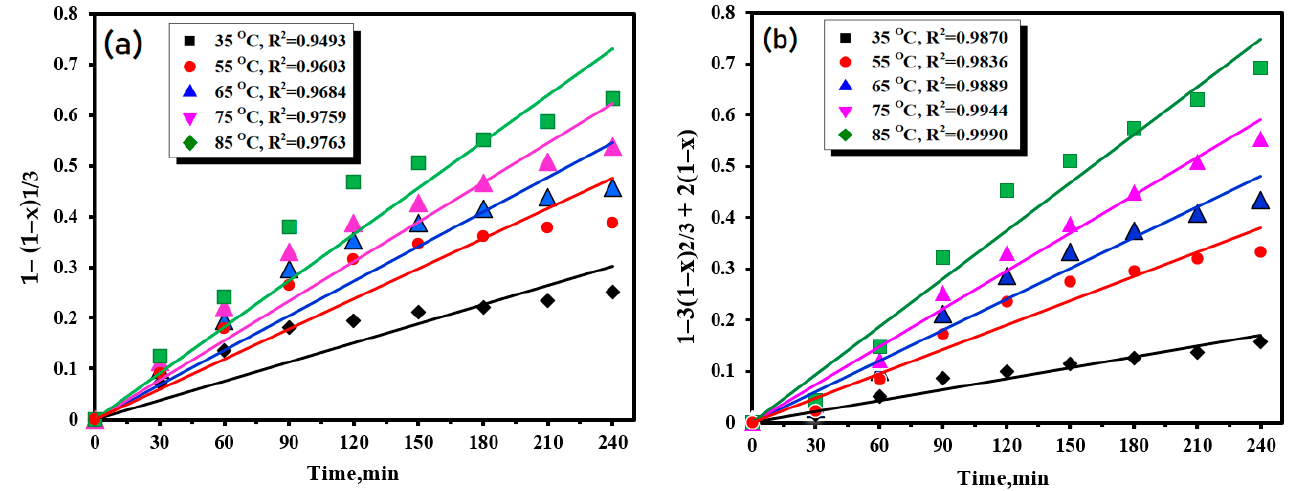
Figure 17. Plot of 1 – (1 – x) 1/3 ( a ) and 1 − 3(1 – x) 2/3 + 2(1 – x) ( b ) vs. time at different temperature.